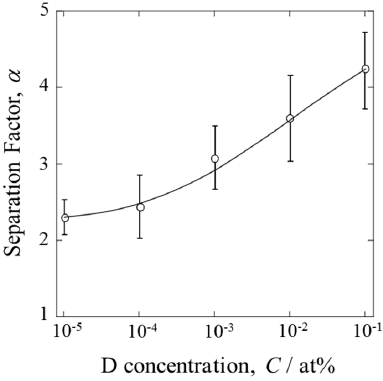
Figure 6 . Dependency of separation factor, α , on fuel gas concentration of D when PEFC was operated at 1.2 A.